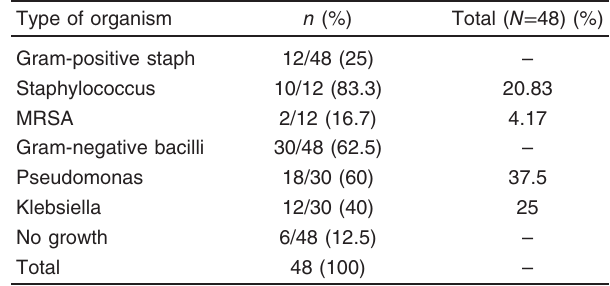
Table 9 Number of patients developed ventilator-associated pneumonia in relation to the type of